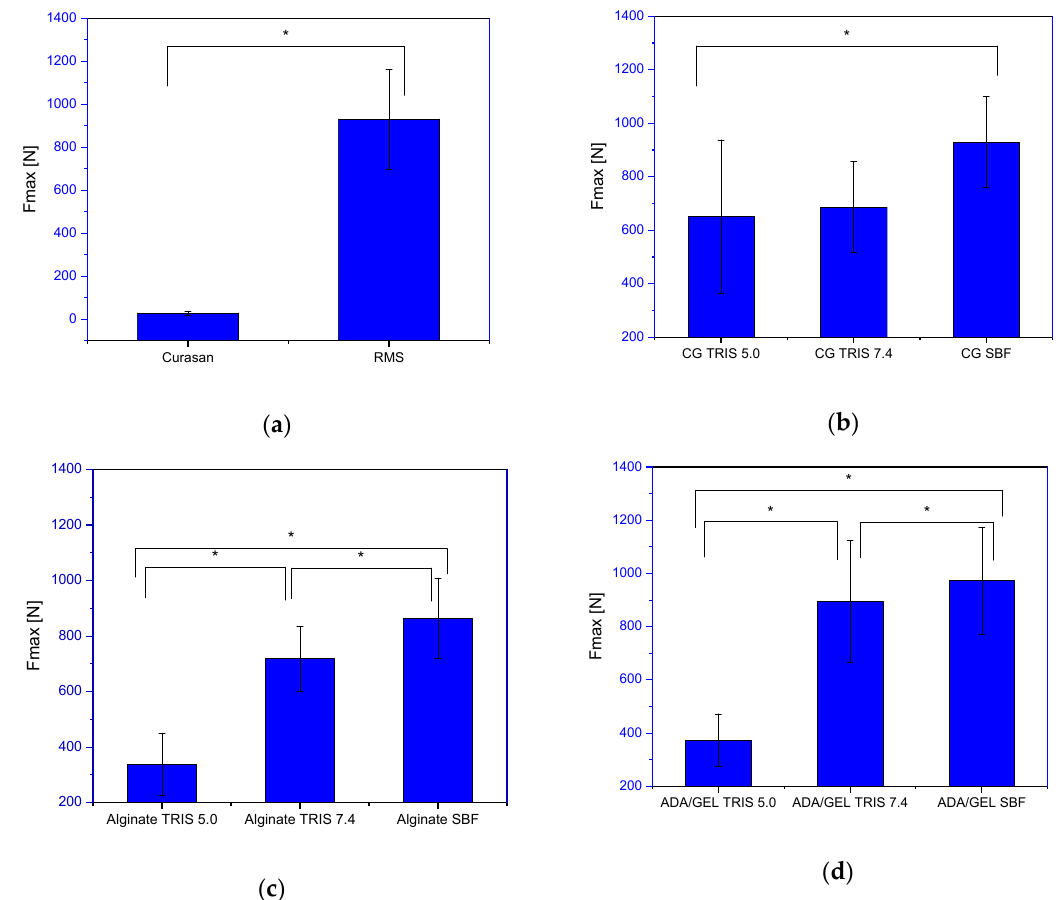
Figure 8. Maximum tolerated force for the different samples; ( a ): Comparison Curasan vs. RMS; ( b ): Control Group after incubation in different buffers for 30 (SBF) or 60 days; ( c ): Alginate loaded RMS ceramics after incubation in the different buffers for 30 (SBF) or 60 days; ( d ): ADA/GEL loaded RMS ceramics after incubation in the different buffers for 30 (SBF) or 60 days; the measurements was performed on ZWICK/Roell Z005 Universal Testing machine; * significant difference with p < 0.05.